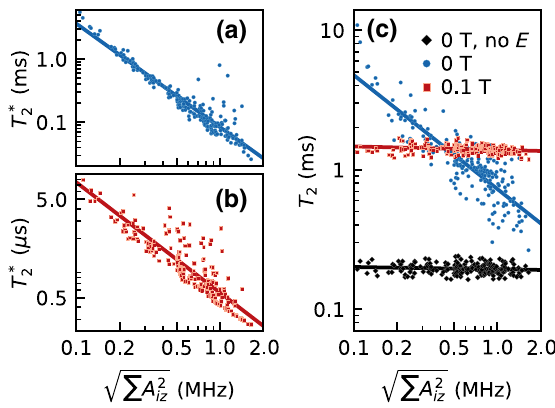
FIG. 5. Single defect coherence times T ∗ V C V Si divacancy at zero and high magnetic fields for different bath couplings. (a),(b) The coherence time T ∗ high (b) fields as a function of the square root of the sum of squares of the hyperfine couplings with bath spins Significant deviations from the least-squares fit (solid lines) are present for systems containing single nuclear spins with high hyperfine coupling, and the coherence decay may not be approxi- mated by a single exponential [39]. (c) The coherence time T 2 for zero (blue) and high (red) magnetic fields, and for a hypothetical system with E = 0 MHz at zero field (black). All calculations are performed for SiC with natural isotope concentration for the weakly coupled nuclear